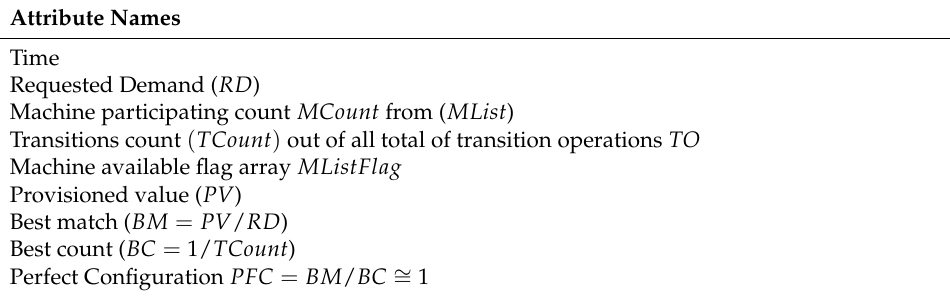
Table 6. Schema of Optimized Elastic Scaling.